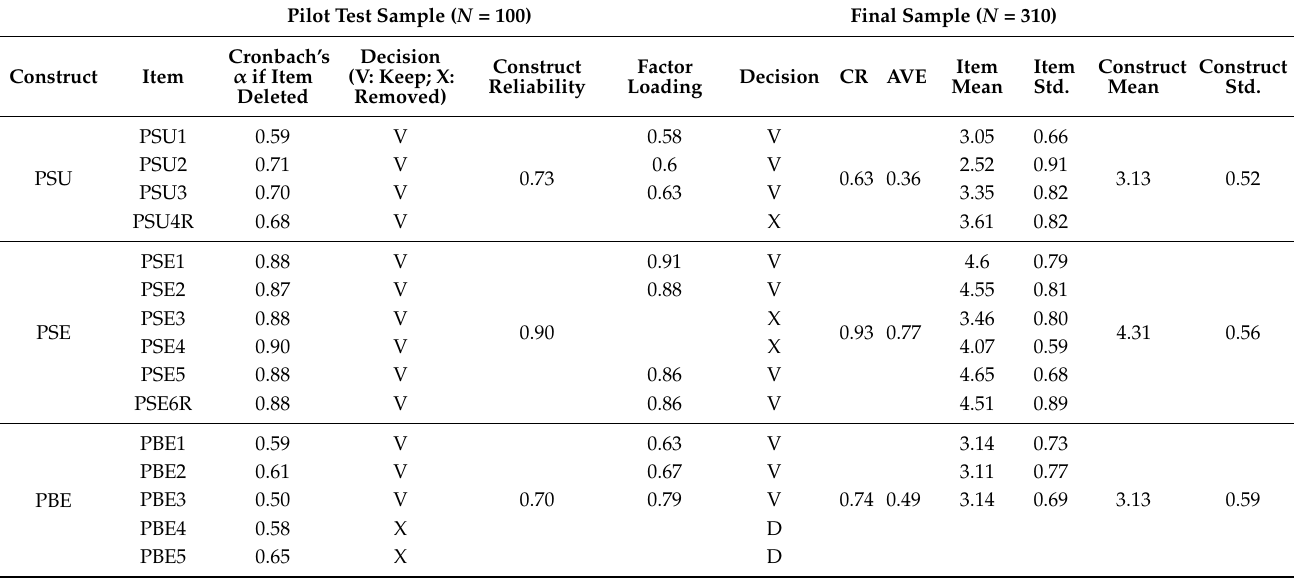
Table 2. Mean, standard deviation, Cronbach’s α values, factor loading, composite reliability (CR), the average variance extracted (AVE) of questionnaire items and constructs from the pilot test sample and the final